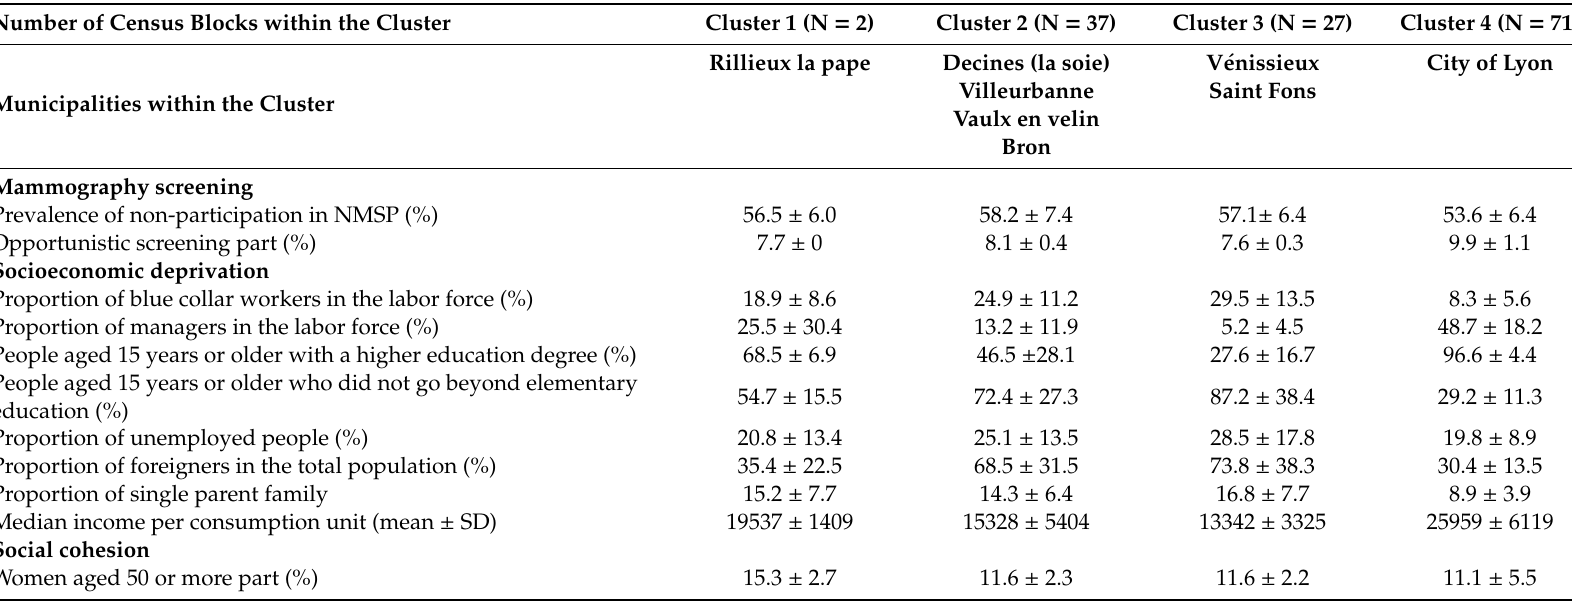
Rillieux la pape V é nissieux